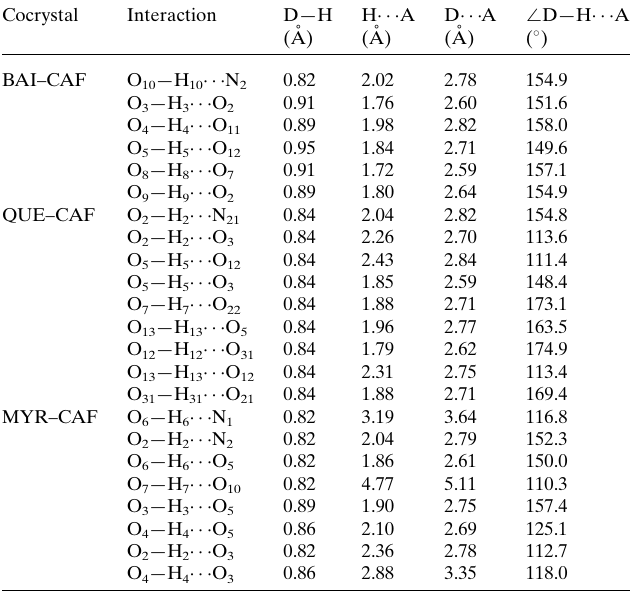
Table 3 Selected hydrogen-bond distances and parameters for the cocrystals. Cocrystal Interaction